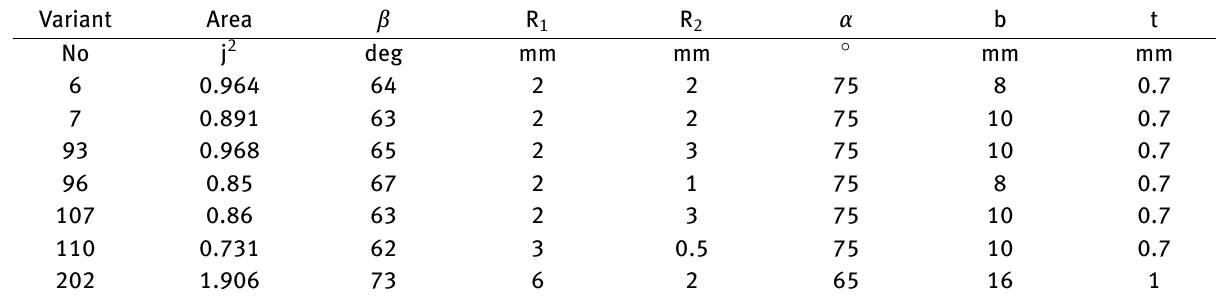
Table 1: Compilation of the average values of the inclination angles of the unload curve, the relative hysteresis surface area, and the characteristic dimensions of the gaskets that met all the limitations